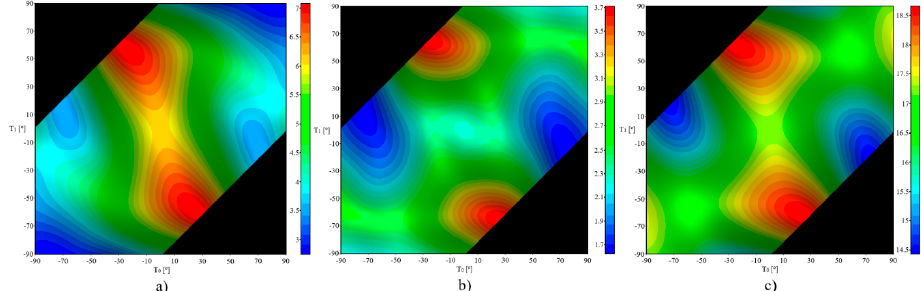
Figure 4. Contour plots. ( a ) buckling uniaxial, ( b ) buckling biaxial, and ( c ) frequency.